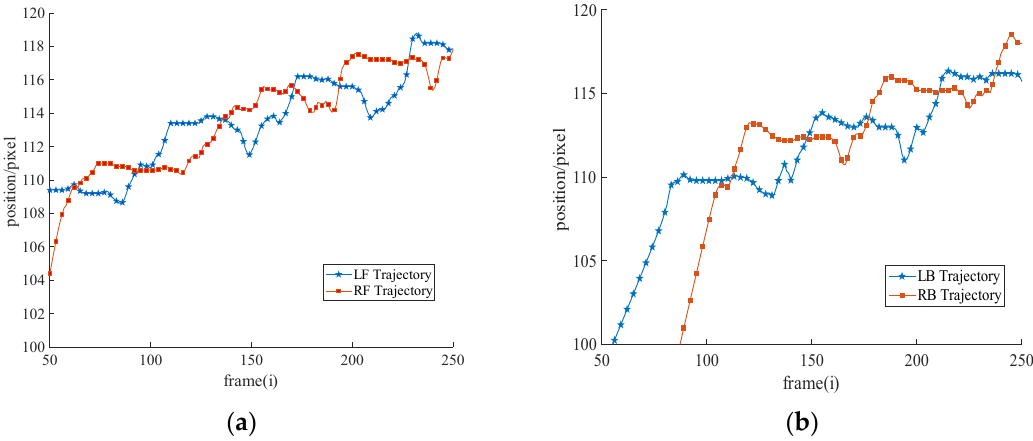
Figure 22. ( a ) Foot trajectory of horse’s forelimbs; ( b ) foot trajectory of horse’s hindlimbs.